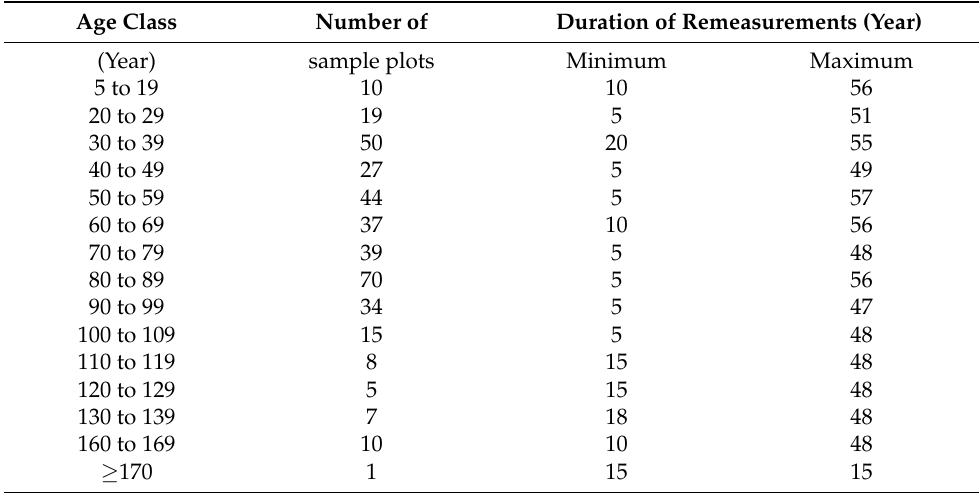
Table 3. Number of sample plots in different age classes and minimum and maximum duration of remeasurements. For each sample plot, age class consists of stand age at first measurement.